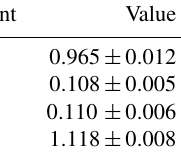
Figure 7. Profiles of the volume linear depolarization ratio for the 3h period in the cloud region, using the three pairs of signal ratios presented in Eqs. (41), (43), and (44). The error bars include the statistical and systematical uncertainties. The dashed lines indicate the mean height range (of 240m) at which the calculation of the interchannel constants was performed.